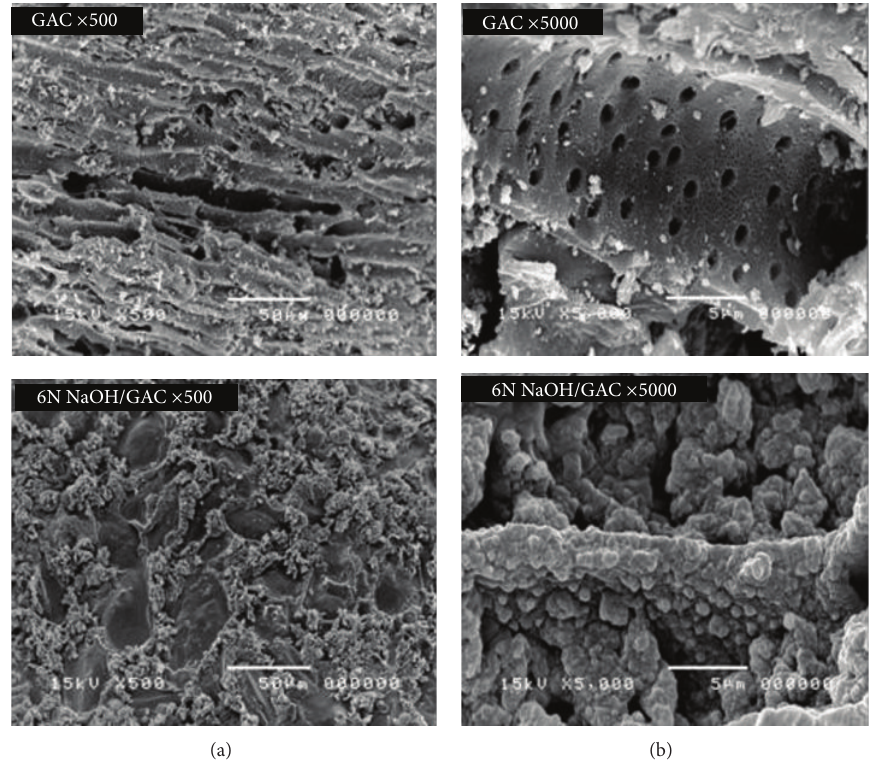
Figure 3: SEM images of GAC and NaOH/GAC; (a) external surface and (b) cross-sectional surface.